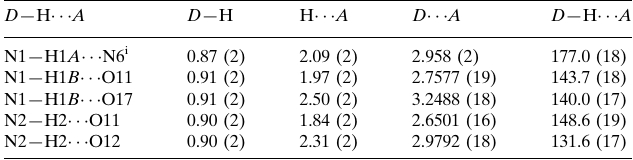
The geometric parameters of the title compound,